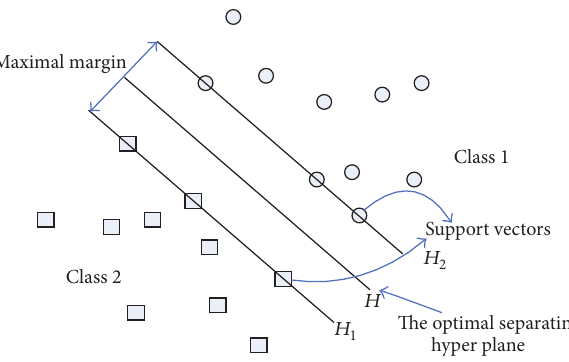
Figure 1: The optimized separating hyper plane in classification.